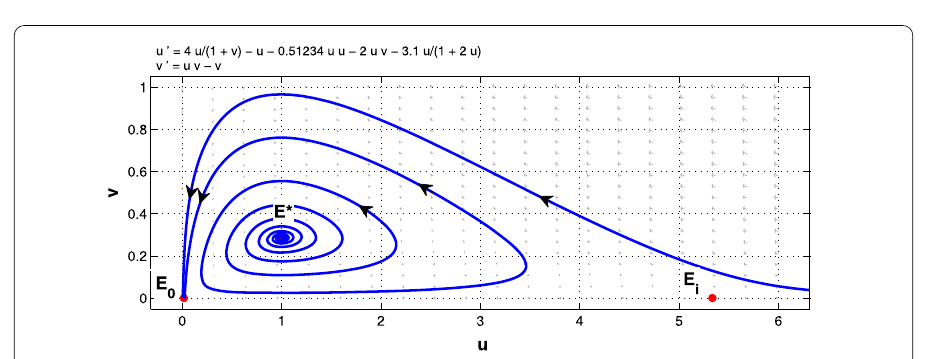
Figure 3 Dynamic behavior of system (1.1) with r 0 = 4, k = 1, d = 1, a = 0.51234, p = 2, E = 1, m 1 = 1, m 2 = 2, c = 0.5, q = 3.1 > 2.30553 = q H , E ∗ is